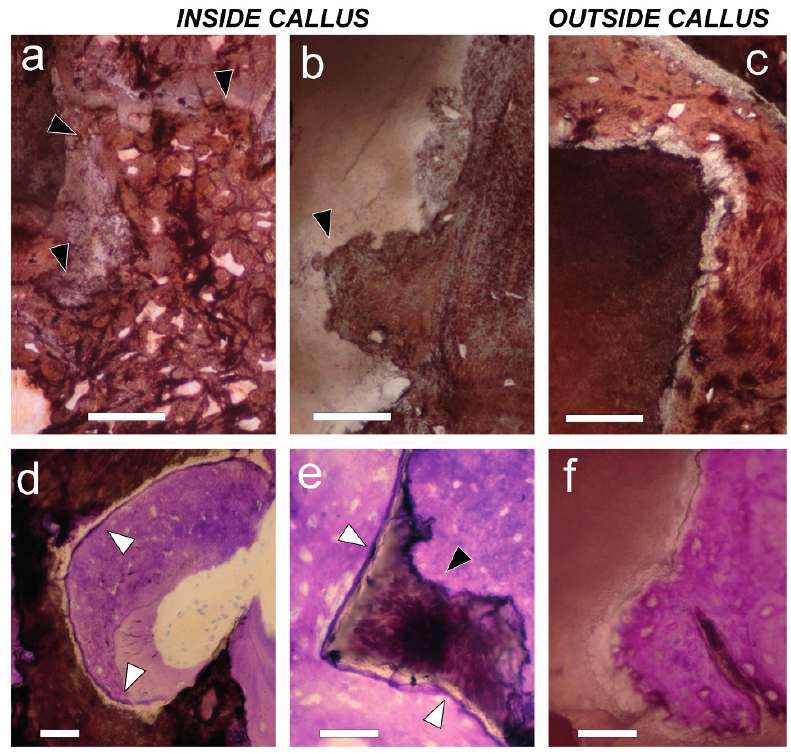
Figure 6. Histology of mineral scaffold surfaces with deposited bone tissue. ( a , b ) On the left side (the HA group ( a )), and on the right side (HA + MSCs group ( b )), mineral scaffolds found inside the callus have an eroded contour (black arrows) that indicates previous osteoclastic resorption; ( c ) On the contrary, the mineral scaffold outside the callus on the right side (HA + MSCs group) does not; ( a – c ) von Kossa staining. Bar = 50 µm; ( d , e ) Inside callus, on left side; In the HA group ( d ), as well as on the right side (HA + MSCs group ( e )), mineral scaffolds show a peripheral cement line (white arrows) that has been deposited before bone formation; ( f ) On the contrary, a cement line is not observed on the mineral scaffold surface when mineral scaffolds are found outside the callus on the right side (HA + MSCs group); in this case, bone tissue was formed by adding cells directly onto the mineral scaffold surface. Toluidine blue/pyronin G staining. Bar = 50